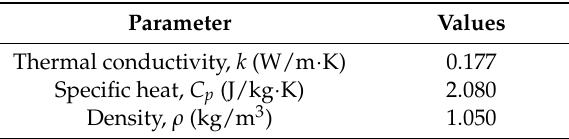
Table 1. Thermal properties of